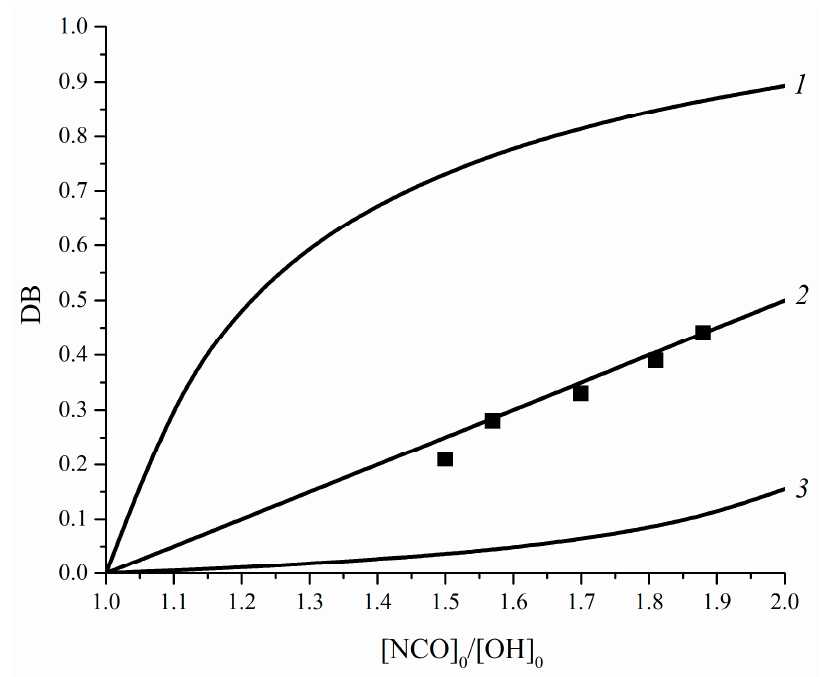
Figure 5. Correlation between DB calc and initial ratio [NCO] 0 /[OH] 0 for positive substitution effect (1), k 2 / k 1 = 10; statistic polyaddition (2), k 2 / k 1 = 1; negative substitution effect (3), k 2 / k 1 = 0.1. Experi- mental data for synthesized polyurethane-triazoles are shown by solid squares.